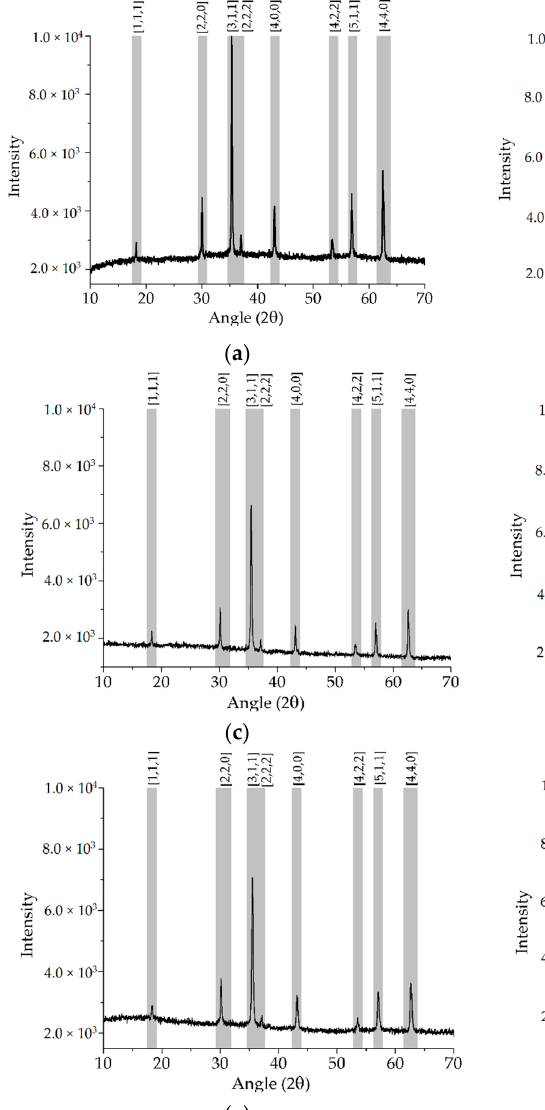
Figure 2. UV-VIS spectra in ethanol of ( a ) cuboid hybrid nanoparticles and ( b ) spheroid hybrids hybrid nanoparticles and respective corrole precursor.